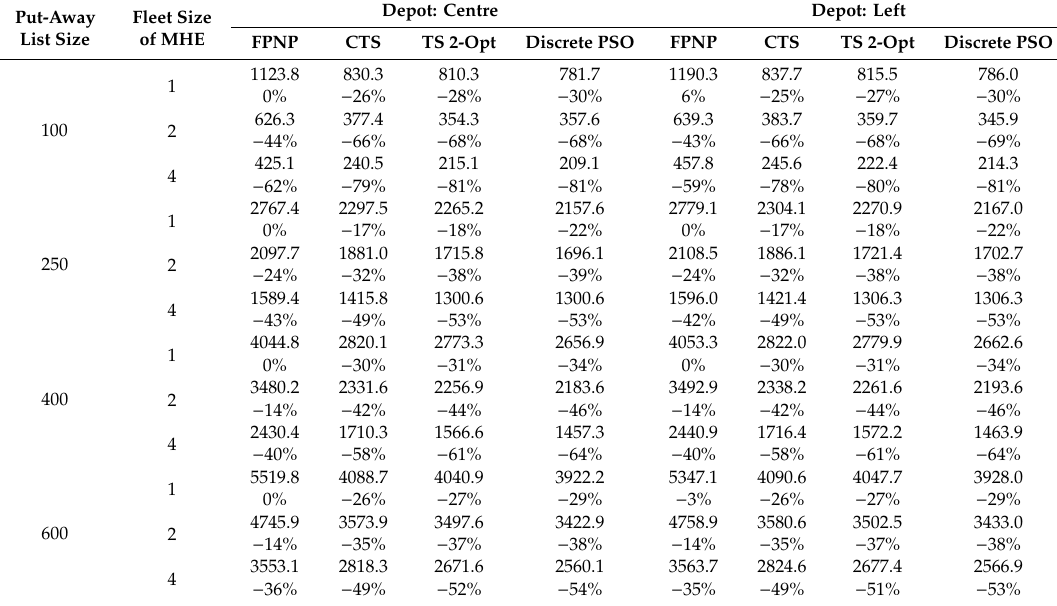
Table 3. Results of the experiments for the PRP.